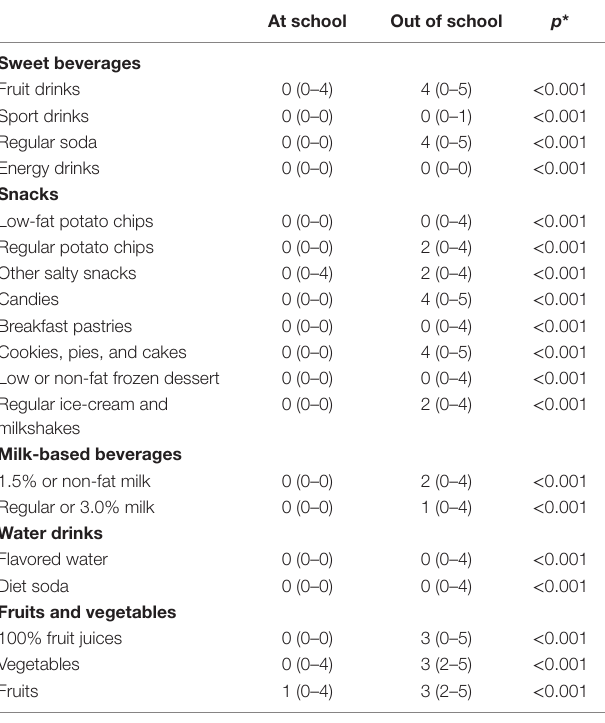
*Differences between the two different environments for each question (outcome) were assessed by Wilcoxon signed-rank test for dependent samples (a child reported consumes at school and out of school).